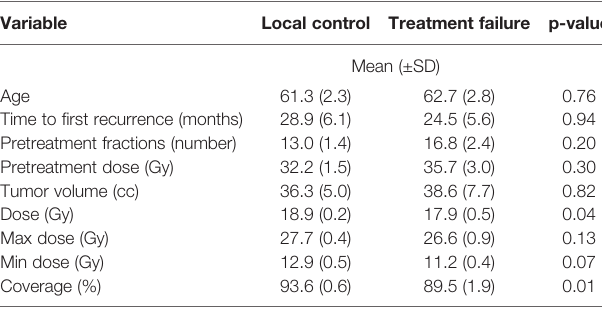
TABLE 3 | Comparison between locally-controlled and uncontrolled patients. Variable